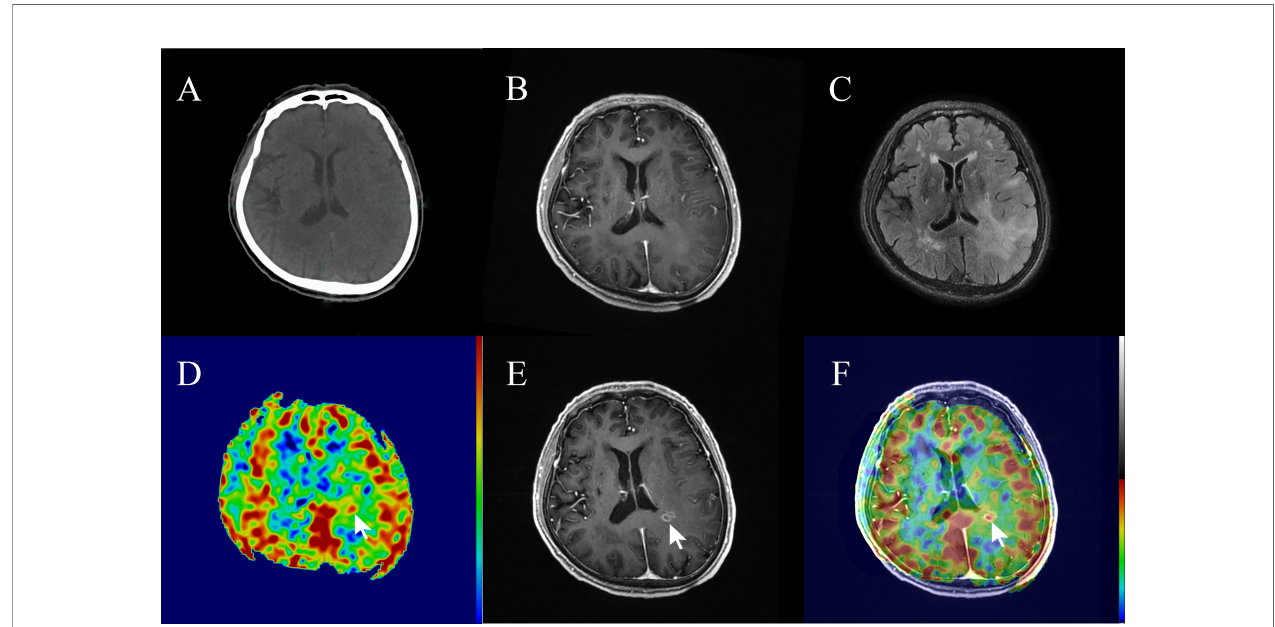
FIGURE 5 | A 74-year-old patient with non-enhancing low-grade glioma (WHO grade II astrocytoma) showed focal contrast enhancement within a prior non- enhanced and high-perfusion area at 20 sessions of radiotherapy (40 Gy). (A) Planning plain-CT image. (B) Contrast-enhanced T1-weighted imaging (CE-T1WI) before radiotherapy. (C) T2 fl uid-attenuated inversion recovery (T2 Flair) image before radiotherapy. (D) Three - dimensional arterial spin labeling (3D-ASL) image before radiotherapy. (E) CE-T1WI at 20 sessions of radiotherapy. (F) Fusion image of (D, E) .